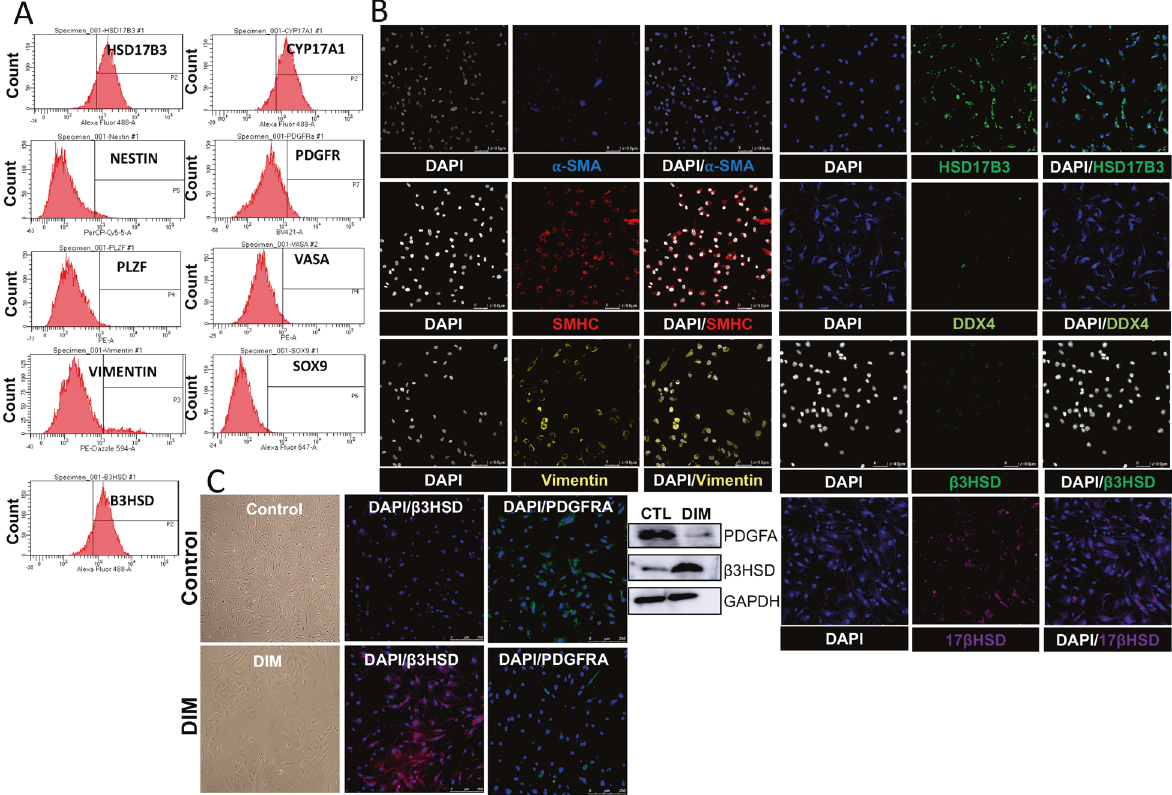
Fig. 1 Characterization of testicular cells. A Flow cytometry results showing the percentage of cell types — Sertoli cells, PMCs, LSCs, ALCs, and germ cells in the TME. B Immunostaining results showing characterization of cell types in the TME at protein levels. C Transformation of LSCs to ALCs in the presence of differentiation-inducing media as indicated by the reduced expression of PDGFR α and increased expression of